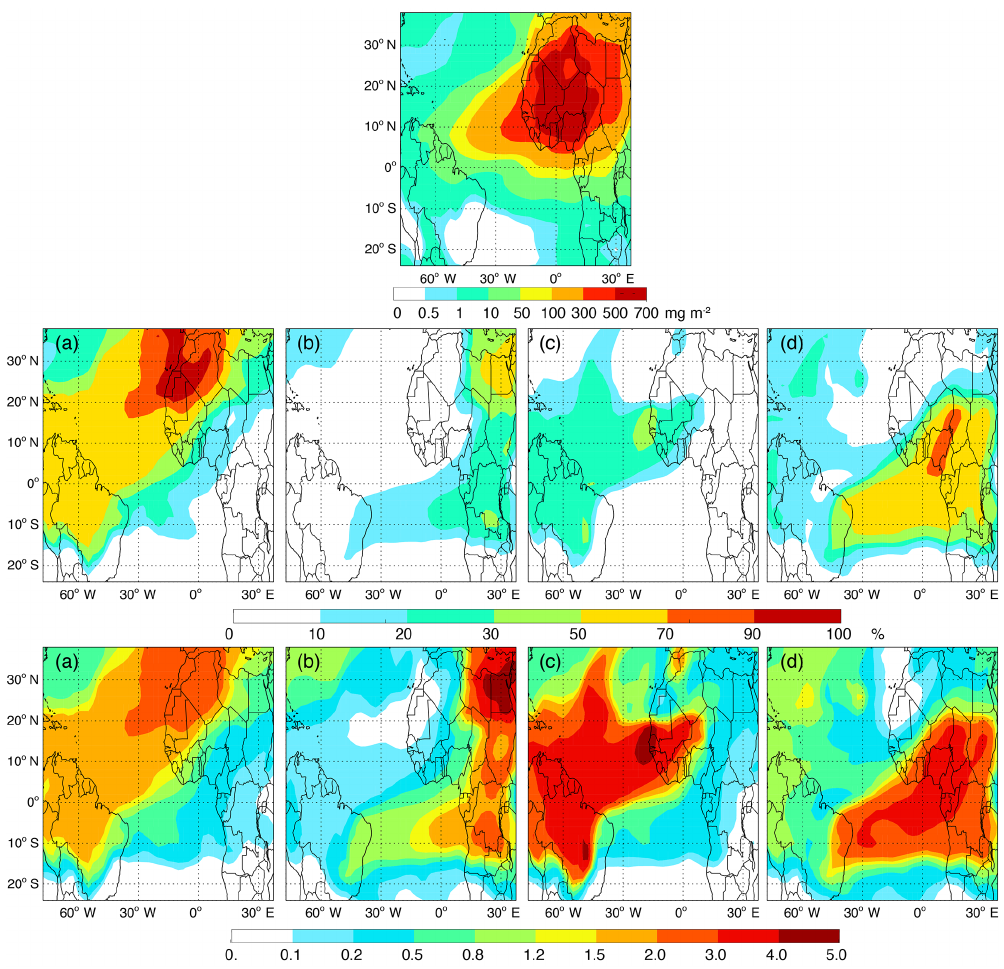
Figure 8. Column burden of total dust (top panel) and the contribution (middle panels) to total dust burden from four defined source regions ( a , northwestern Sahara; b , northeastern Sahara; c , western Sahel; d , Bodélé) over the rectangle region between 80 ◦ W–40 ◦ E and 25 ◦ S– 40 ◦ N from January to April 2014. The bottom panels are the sensitivity of the dust burden to the emission from the four source regions, with high values indicating high sensitivity (see